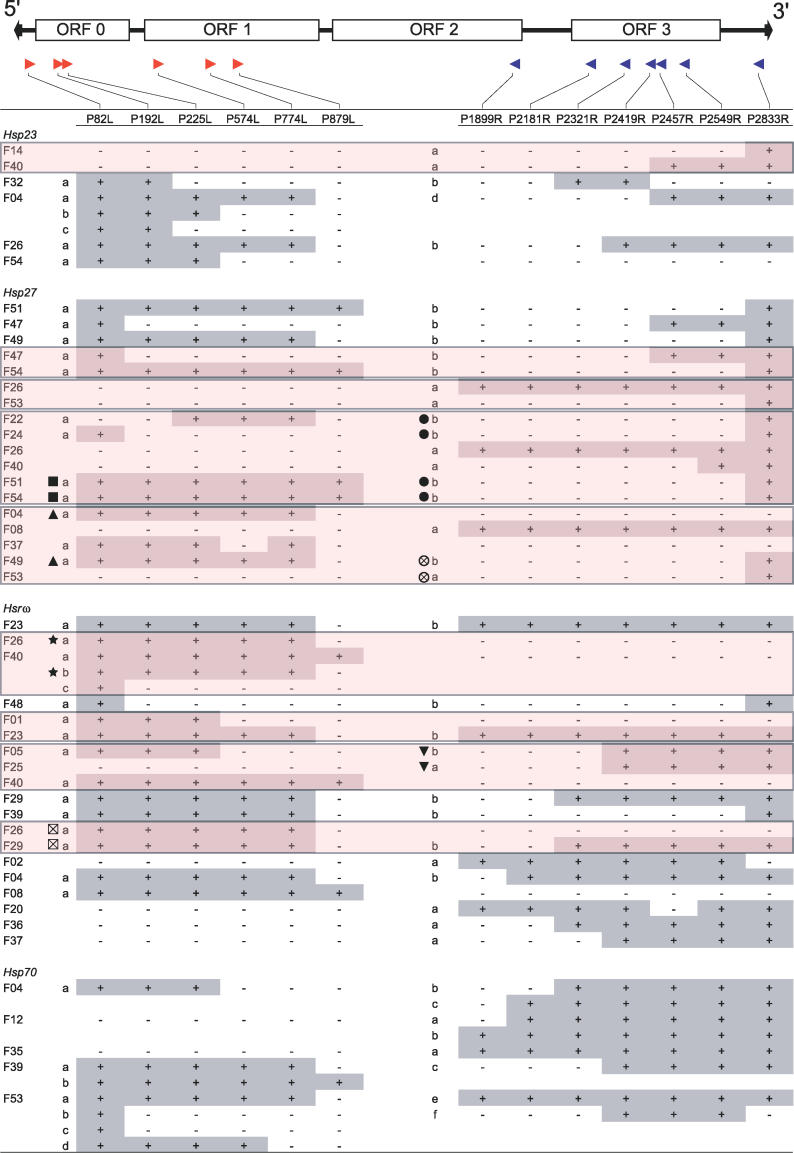
Distinctive P Elements Revealed by Re-screening a Random Sample of P Element Insertion Sites in Natural Populations for Four Genes, Hsp23, Hsp27, Hsrω, and Hsp70
The P element insertion sites were selected from Gene Set I. A plus sign (+) indicates successful PCR amplification with one primer complementary to the focal gene and another complementary to a unique sequence in the P element (top), and thus reports the size and orientation of the P element; a minus sign (−) indicates no amplification. Table S7 provides sequences of these primers. At each insertion site in a population, one to six distinctive P elements segregated; these are designated a–f. For Hsp23, Hsp27, and Hsrω, nine insertion sites shared by two or more natural populations (indicated by boxes) and 17 unique insertion sites were re-screened. Amplicons that share a symbol (filled square [█], filled triangle [▴], filled circle •], etc.) occurred at the same integration site in different populations and were indistinguishable by size or orientation. For Hsp70, a five-copy gene in natural populations [17], the specific gene of insertion was not determined; thus, each distinctive amplicon (a–f) could represent insertion(s) at the same site in one to five of the Hsp70 genes. For population codes see Figure 1.ORF, open reading frame.